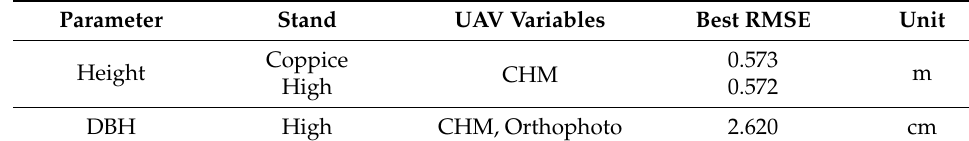
Table 3. RMSE value of H and DBH parameters, estimated from photogrammetric models.